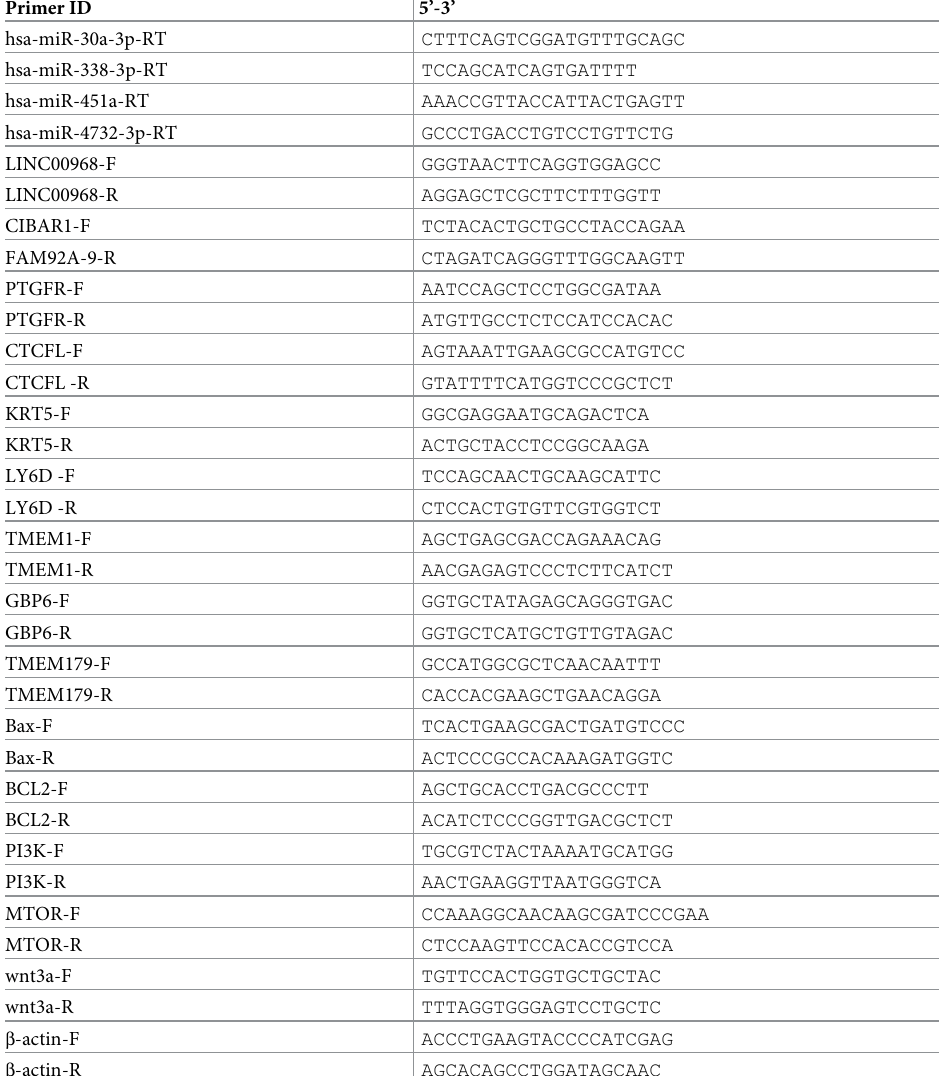
Table 1. The primers used in this